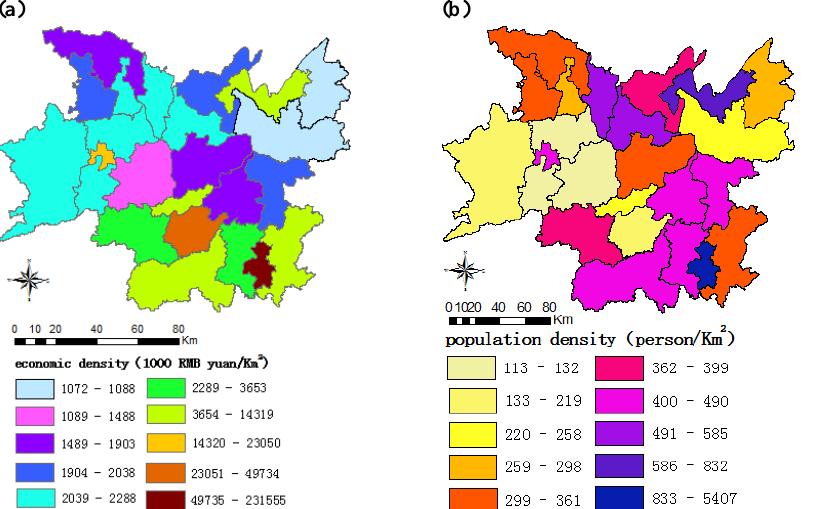
Fig. 6. The economic density (left panel) and population density (right panel) in the Dongting Lake region